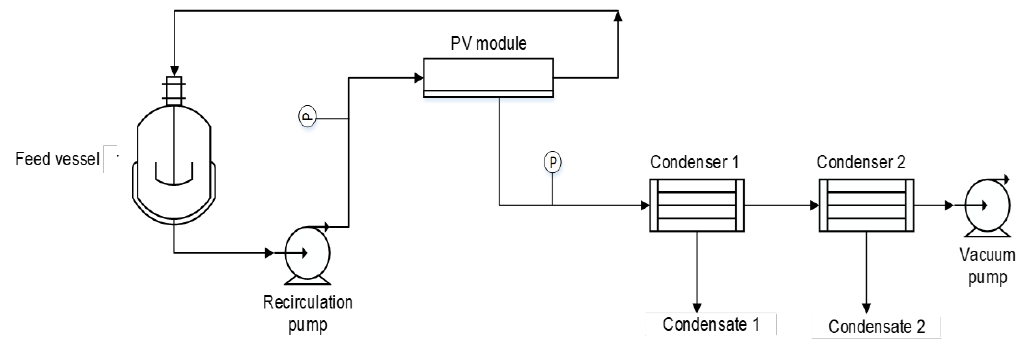
Figure 1. Experimental pervaporation - fractionated condensation laboratory set-up similar to [19]. P is a pressure transducer.